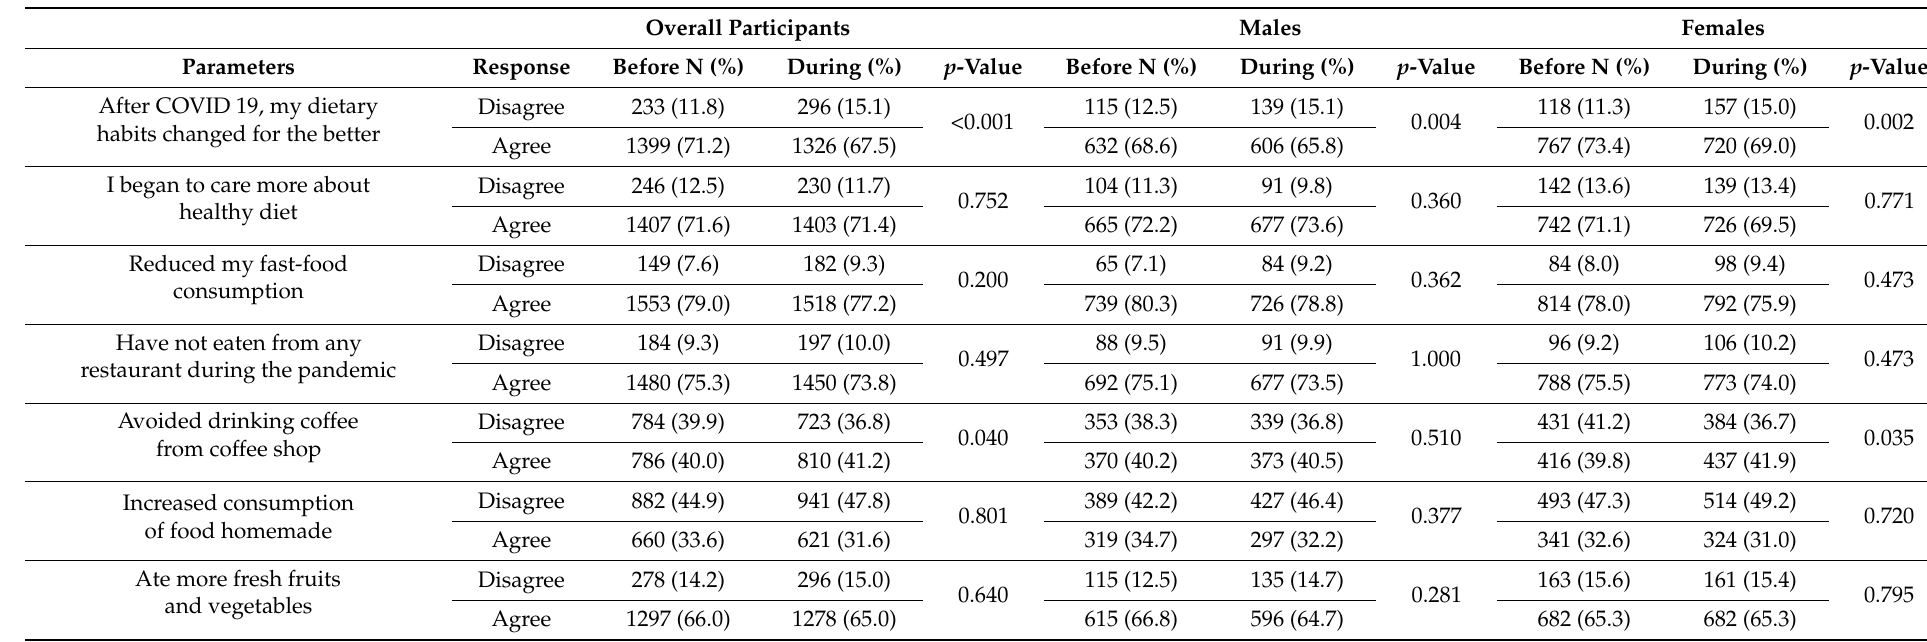
Table 3. Dietary habit and behavior response before and during lockdown among participants (overall and gender based). Overall